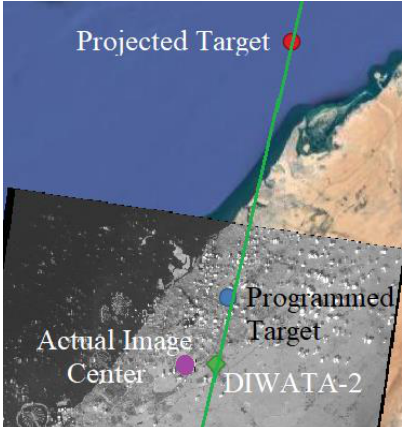
Figure 2. Dubai, UAE. Relative positions.